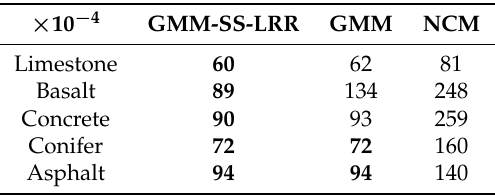
Table 2. The RMSE calculated between the probability value in each histogram and the estimated value at each bin location for the synthetic